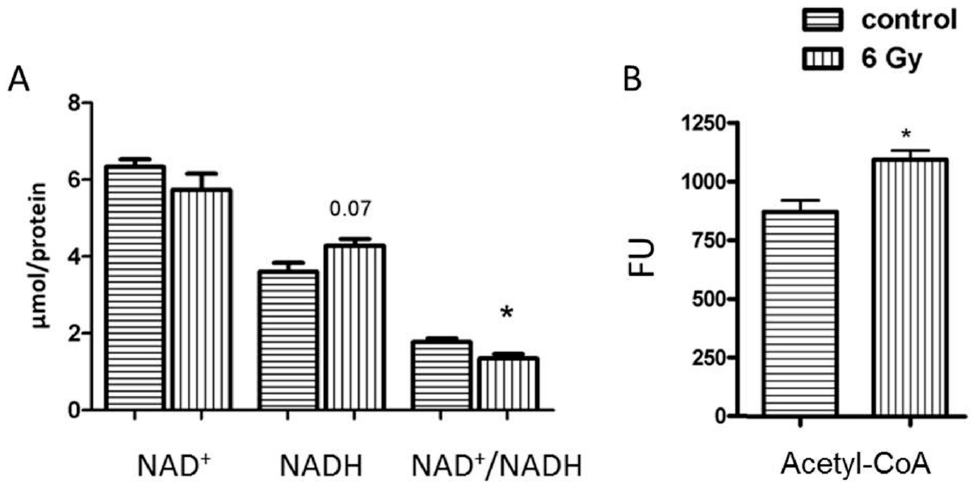
Figure 5. Analysis of the mitochondrial NAD + , NADH and NAD + /NADH and Acetyl-CoA. The concentration of NAD + , NADH and NAD + /NADH ( A ) and Acetyl-CoA ( B ) was compared in samples from irradiated and control groups. The error bars represent standard error of the mean (± SEM) (t- test; * p < 0.05; n =